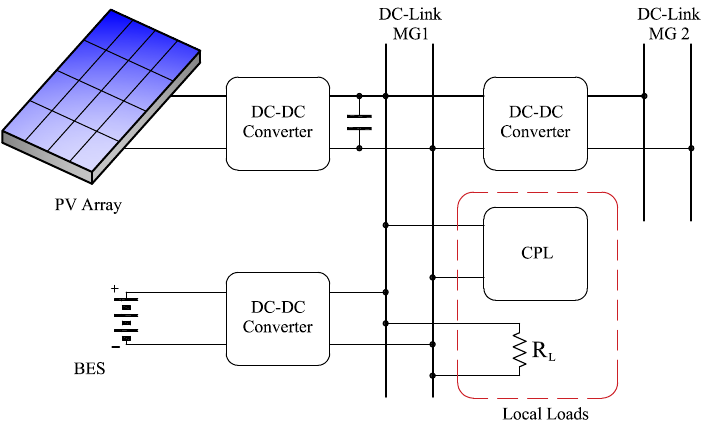
Figure 1. Isolated DC microgrid supplying a constant power